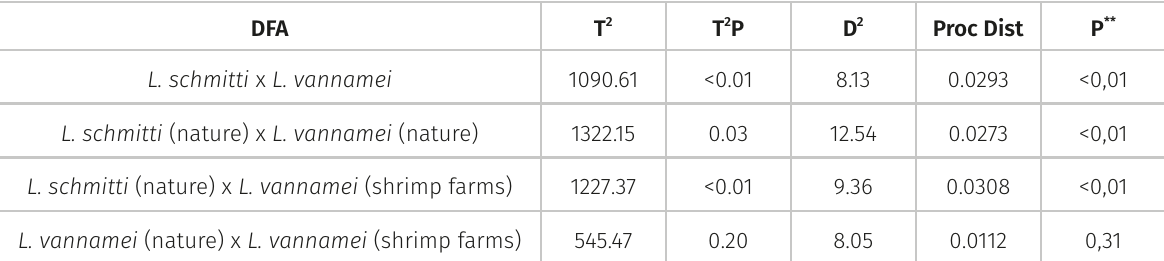
Table II. Statistical results for comparison of shape variation between grouping factors ‘species’ ( L. schmitti and L. vannamei ) and ‘origin’ (nature and shrimp farms) . DFA T 2 T 2 P D 2 Proc Dist P